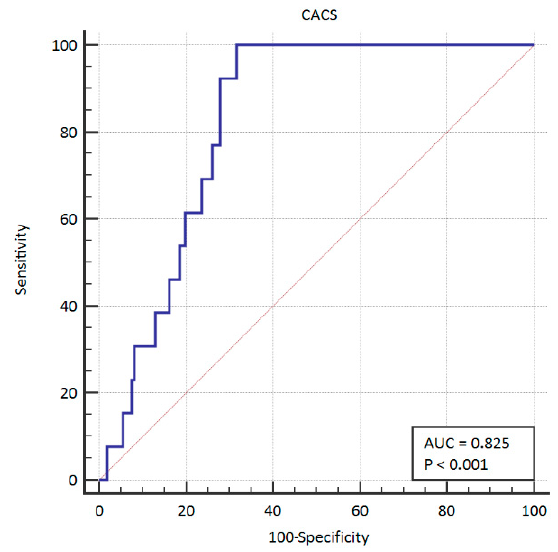
Figure 2. ROC curve for CACS in CABG. ROC: receiver operating characteristics; CABG: coronary artery bypass surgery.